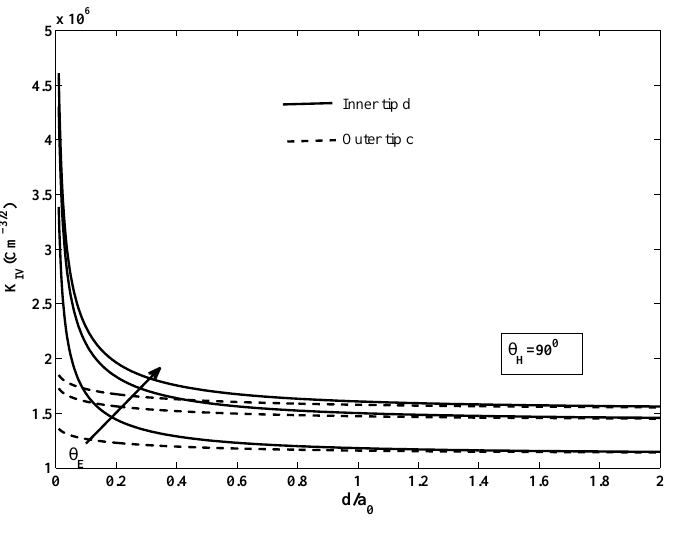
Fig. 7 EDIF versus inter-crack distance for different electric poling with fixed magnetic